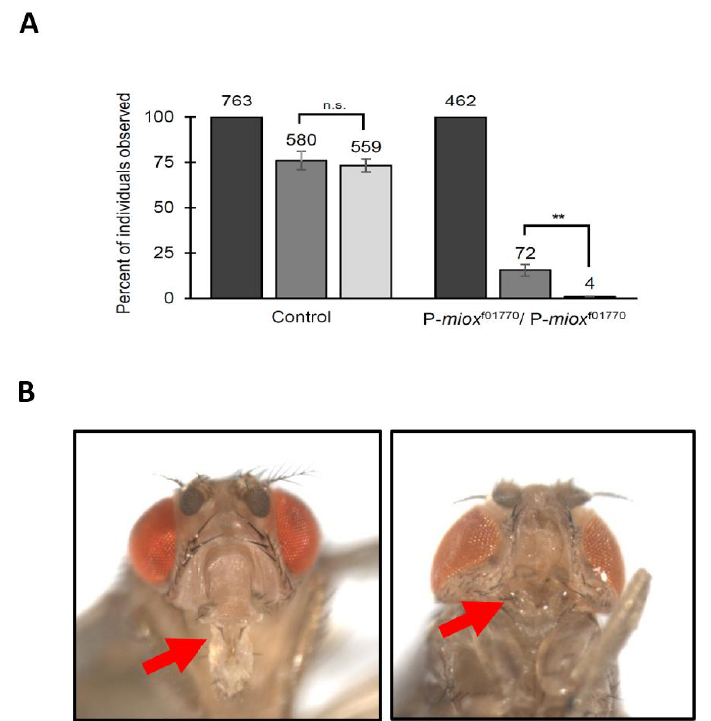
Figure 3. Disruption of myo- inositol catabolism via piggyBac WH -element insertion in MIOX results in developmental defects. ( A ) The percent of adults (light grey bars) eclosing from pupae (medium grey bars), normalized to the number of embryos (dark grey bars) on standard rich food. Strains as indicated. Wild-type control (CS) results shown. N = total number of individuals examined. Mean ± SE of three independent trials are represented. n.s. = not significant, ** p < 0.005, as determined by two-tailed t -test. ( B ) Brightfield microscope images of adult flies after eclosion. On the left is the control heterozygous P- miox f01770 /TbGFP (N = 15) (indistinguishable from the wild-type control Canton-S), and on the right is P- miox f01770 /P- miox f01770 (N = 16). The arrows indicate the pro- boscis in the wild-type or the region lacking the proboscis in the piggyBac WH -element insertion strain.